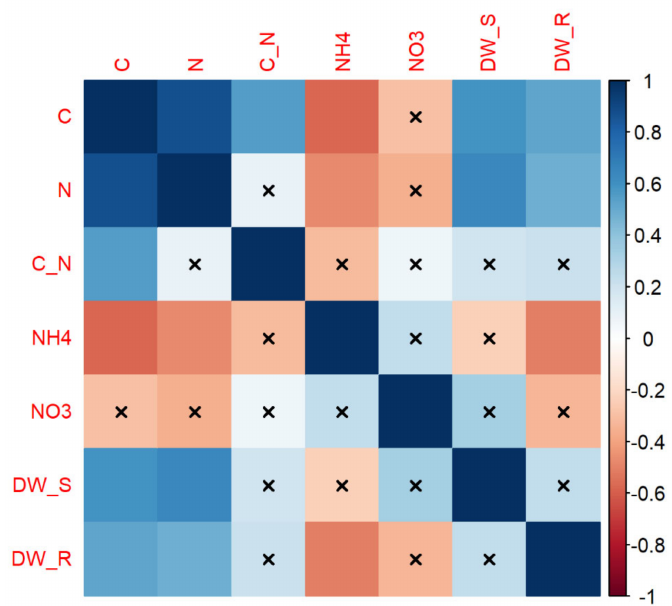
Figure 4. Bivariate correlations (r Pearson) between of the analyzed variables corresponding to total C, N and C/N atomic ratio, NH 4 + and NO 3 concentration, and dry weight roots and shoots (DW_R and DW_S, respectively). Crossed boxes represent nonsignificant correlations. Red boxes show negative correlations, while blue boxes show positive